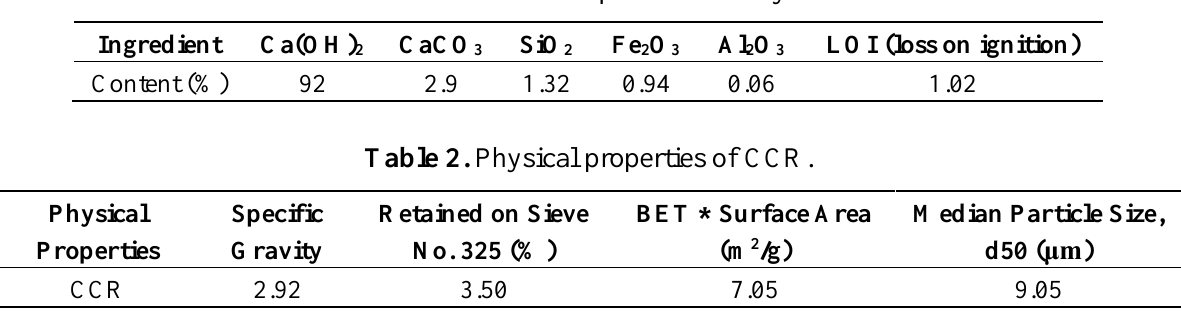
Table 1. Chemical compositions of dry CCR.